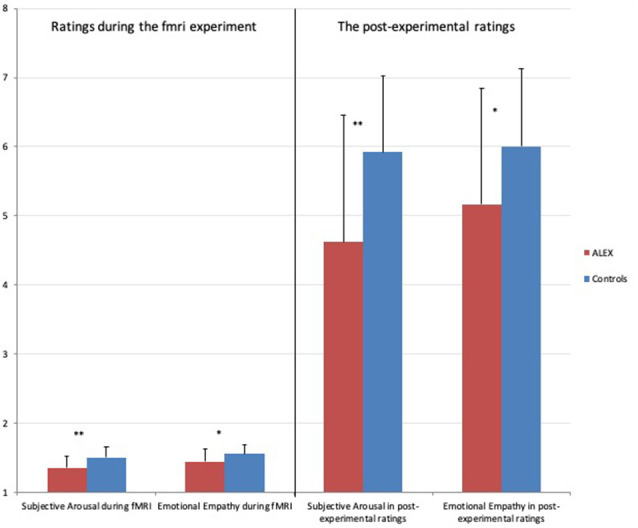
Differences in ratings of subjective arousal and emotional empathy during the fMRI experiment and the post-experiment-ratings. Note: Subjective Arousal during fMRI: ratings of subjective arousal during fMRI experiment range: 1–2, Emotional Empathy during fMRI: ratings of emotional empathy during fMRI experiment range: 1–2, Subjective Arousal in Post-experimental ratings: ratings of subjective arousal in post-experiment range: 1–9, Emotional Empathy in post-experimental ratings: ratings of emotional empathy in post-experiment range: 1–9. The error bars indicate the standard deviation (SD). *p < 0.05, **p < 0.005.